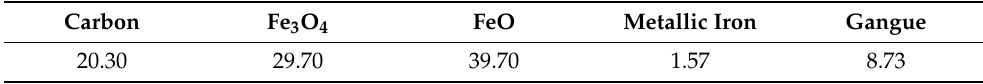
Table 1. Mineralogical composition of CCB: (wt